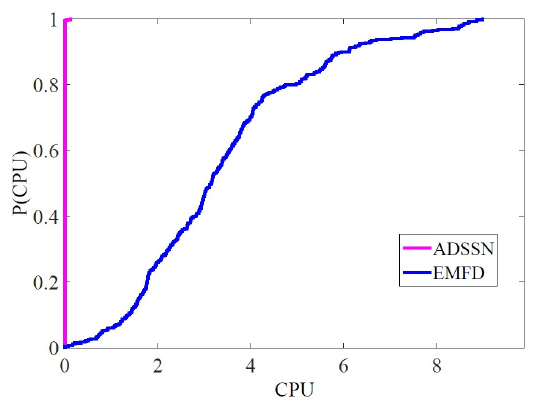
Figure 6. Performance profile of ADSSN versus EMFD [8] with respect to CPU